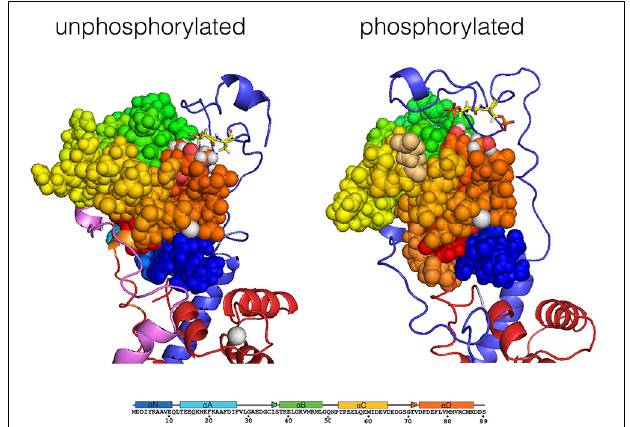
FIGURE 5 | Modulation of the interaction of TnI Ser 22 and 23 with the N terminal lobe of TnC by phosphorylation, determined by molecular dynamics simulations. Average structure after 700ns simulation for unphosphorylated Tn, left. The Tn was phosphorylated in silico after 550ns of simulation and the average structure after a further 200ns is shown, right. The N-terminal lobe of cTnC is shown as spheres with color coding along the peptide chain as indicated by the sequence below; Ser 69 and Thr 71 are colored according to their atoms (oxygen red, hydrogen white). The backbone of cTnI N-terminus is shown in blue; Ser 22 and 23 are shown in yellow in stick representation. Molecular dynamics suggests that with unphosphorylated Tn there is a close interaction of Ser 22 and 23 with cTnC Ser 69 and Thr 71 which is much less prominent when phosphorylated (Gould et al.,